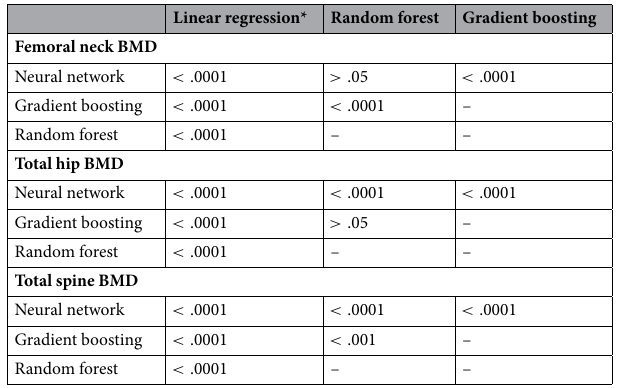
Table 3. Statistical comparisons of mean square errors in the testing dataset ( n = 1026 ) between various models when phenotype covariates and 1103 SNPs were used as the predictors. The Wilcoxon Signed-Rank Test was used to determine all p values. *Lasso regularization with the penalized value of 0.01 was used in the linear